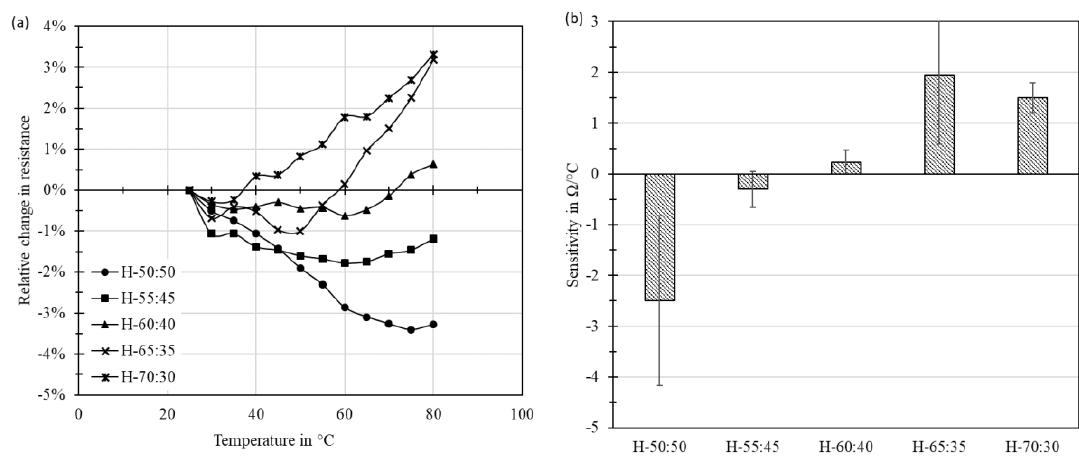
Figure 7. ( a ) Relative change in resistance with temperature for different hybrid samples, and ( b ) sensitivity of the hybrid samples to temperature changes.